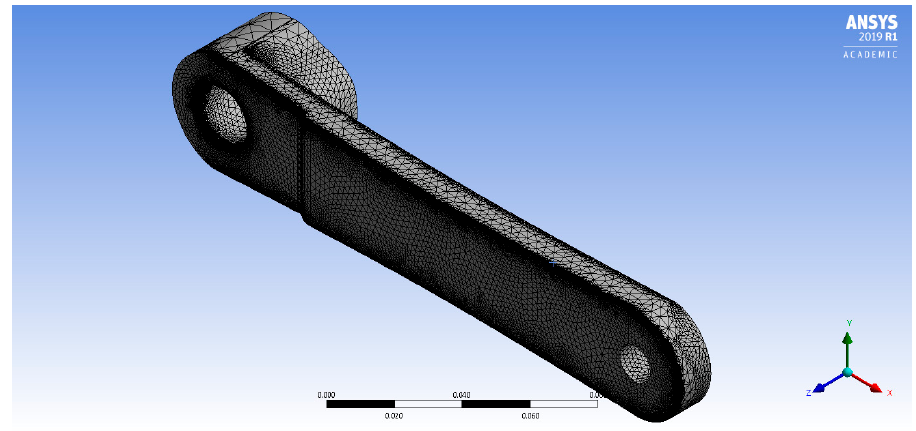
Figure 2. Bicycle crank arm model.